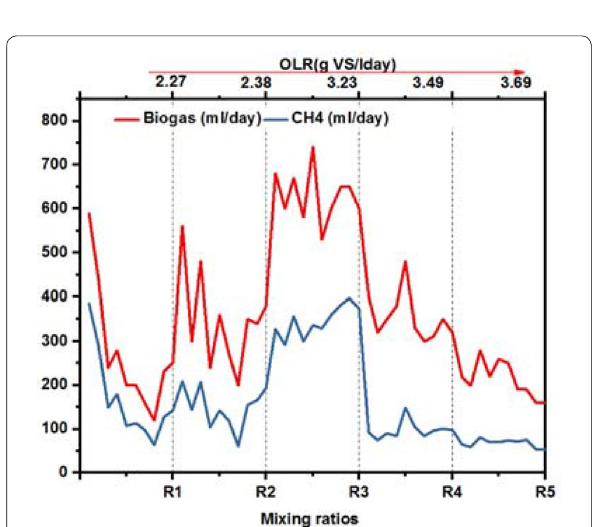
Fig. 4 Rate of biogas and methane production with different mixing ratios and